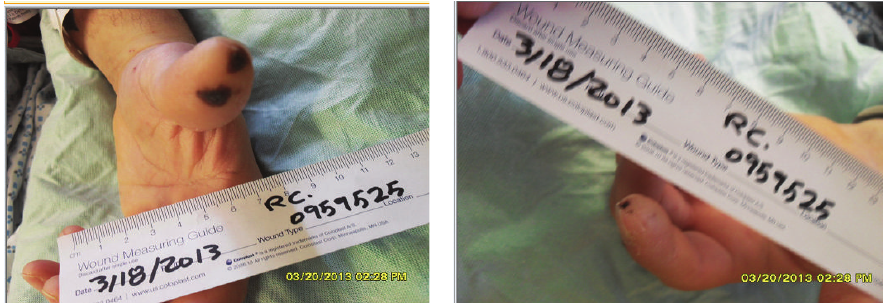
Figure 1: Vasculitic lesions. Multiple embolic lesions were present on the left fourth and fifth fingertips and left first toe.